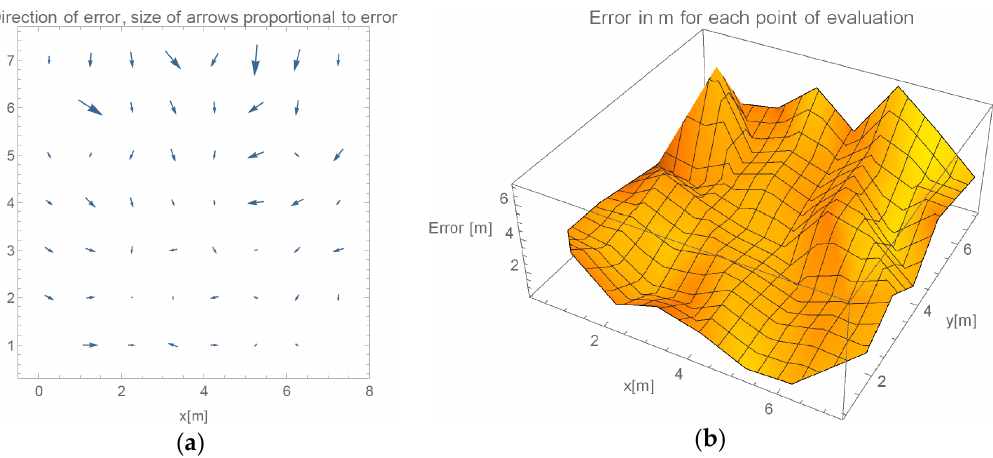
Figure 12. Errors of proposed method ( a ) Direction of errors; and ( b ) value of localization error for each reference point.